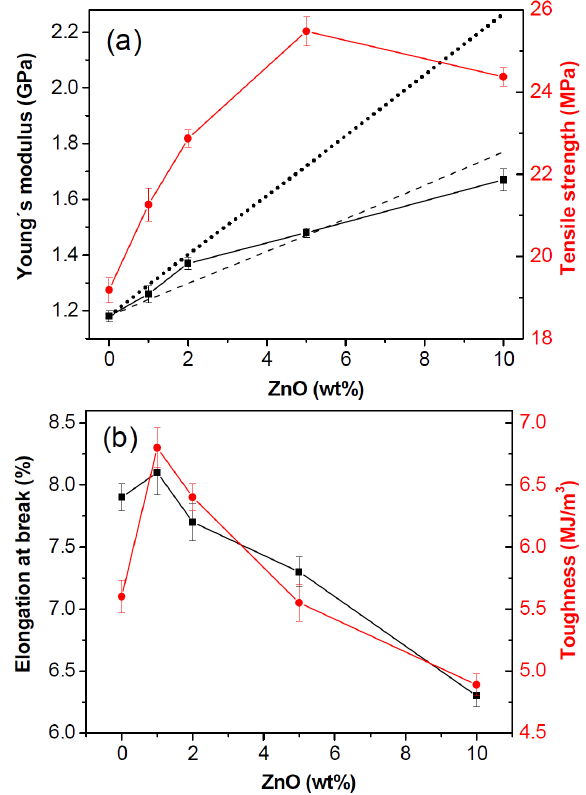
Figure 7. Tensile properties of PHB and PHB/ZnO nanocomposites with different nanoparticle loadings: ( a ) Young’s modulus and tensile strength; ( b ) strain at break and toughness. The dotted and dashed lines in Figure 7a correspond to the predictions according to the Krenchel’s rule of mixtures and Einstein’s equation, respectively (see explanation in the